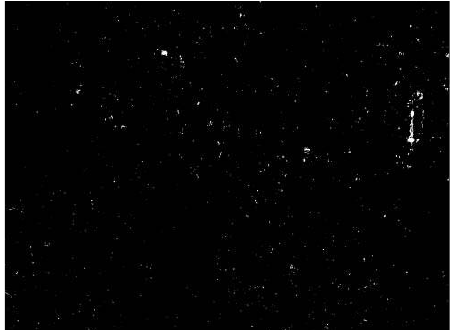
Figure 6. Final change detection result